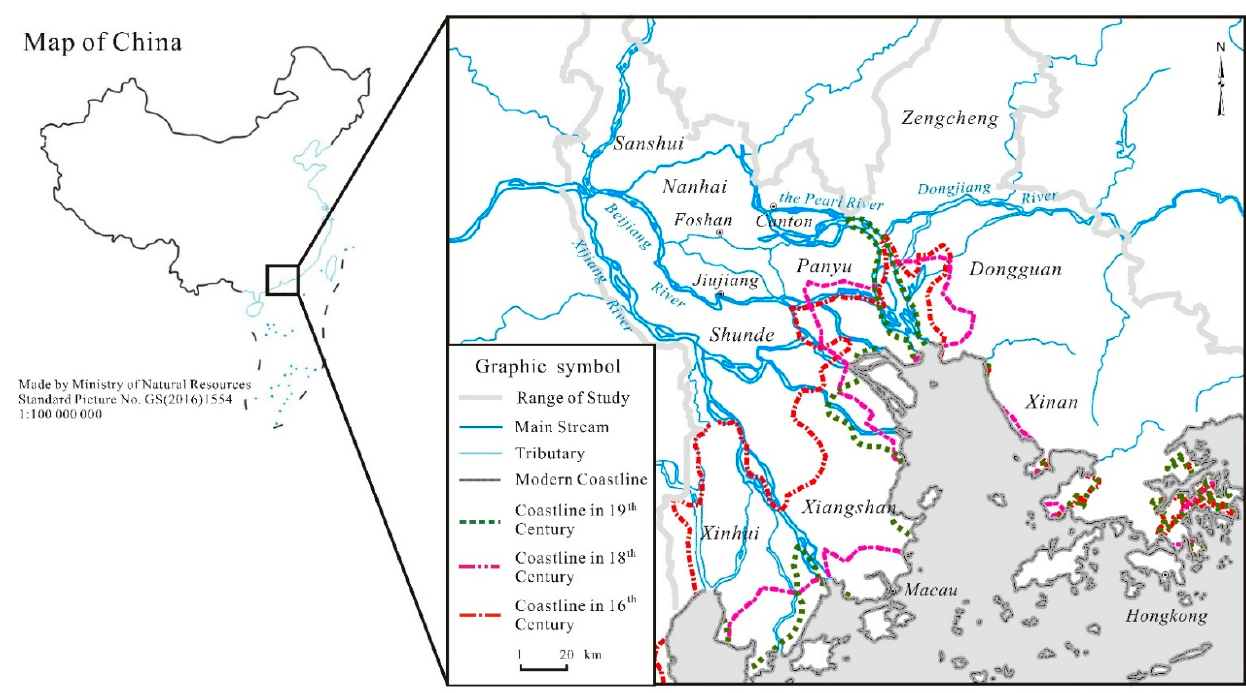
Figure 1. Schematic diagram of area division 1 .